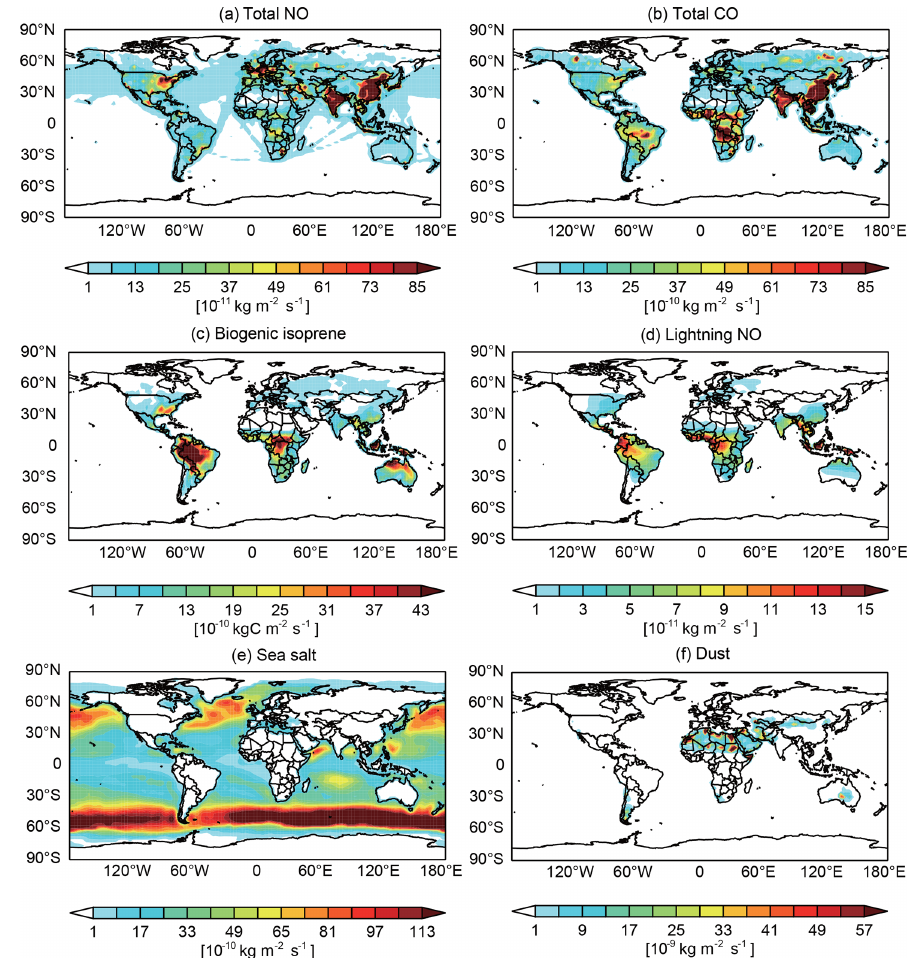
Figure 2. Spatial distributions of annual total emissions used in the study: (a) total NO emissions (not including lightning emissions), (b) total CO emissions, (c) biogenic isoprene emissions, (d) lightning NO emissions, (e) sea salt emissions (dry mass), and (f) mineral dust